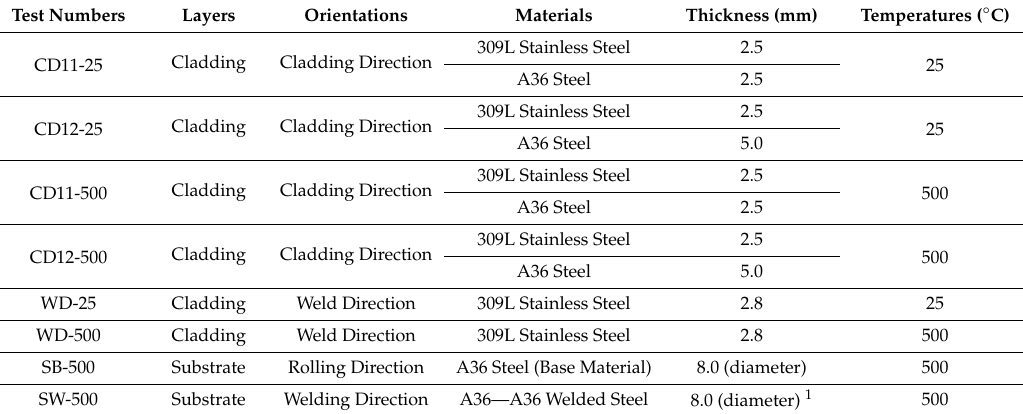
Figure 5. The tensile testing specimens: ( a ) Tensile (flat) specimens location on cladding surface; ( b ) Tensile (rod) specimen location on A36—A36 welded plate. Table 5. Considered conditions in the tensile tests.